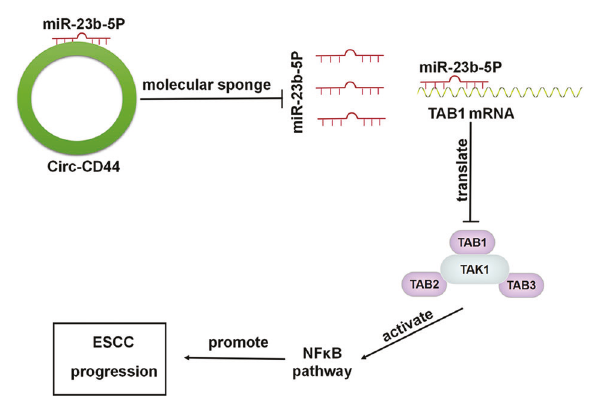
Fig. 8 Hsa_circ_0021727 promotes ESCC cell proliferation, invasion, and migration by activating the TAB1/NF κ B pathway. A and C Wound healing assays demonstrating the migration ability of KYSE510 and TE-1 cells overexpressing hsa_circ_0021727 or knocked down for TAB1 . B and D Wound healing assays demonstrating the migration ability of KYSE510 and TE-1 cells overexpressing hsa_circ_0021727 and treated with INH14. E Transwell assays showing the invasion ability of KYSE510 cells and TE-1 cells overexpressing hsa_circ_0021727 or knocked down for TAB1 . F Transwell assays showing the invasion ability of KYSE510 cells and TE-1 cells overexpressing hsa_circ_0021727 and treated with INH14. G Three-dimensional (3D) spheroid invasion assays revealed the invasion ability of KYSE510 and TE-1 cells overexpressing hsa_circ_0021727 or knocked down for TAB1 . H 3D spheroid invasion assays demonstrating the invasion ability of KYSE510 and TE-1 cells overexpressing hsa_circ_0021727 and treated with INH14. I and J MTT assays showing the proliferation ability of KYSE510 and TE-1 cells overexpressing hsa_circ_0021727 or knocked down for TAB1 . K and L MTT assays showing the proliferation ability of KYSE510 and TE-1 cells overexpressing hsa_circ_0021727 and treated with INH14. M Colony formation assays indicating the cell proliferation capability of KYSE510 and TE-1 cells overexpressing hsa_circ_0021727 or knocked down for TAB1 . N Colony formation assays indicating the cell proliferation capability of KYSE510 and TE-1 cells overexpressing hsa_circ_0021727 and treated with INH14. Values are expressed as the means ± SD; * P < 0.05.